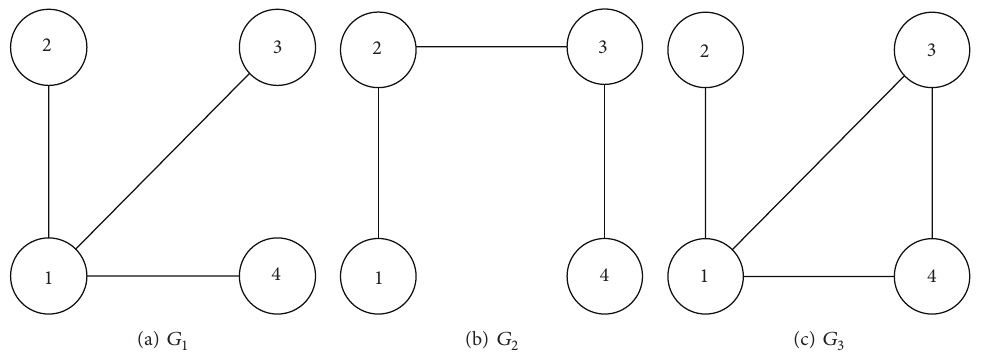
Figure 1: Three interconnection topology graphs.